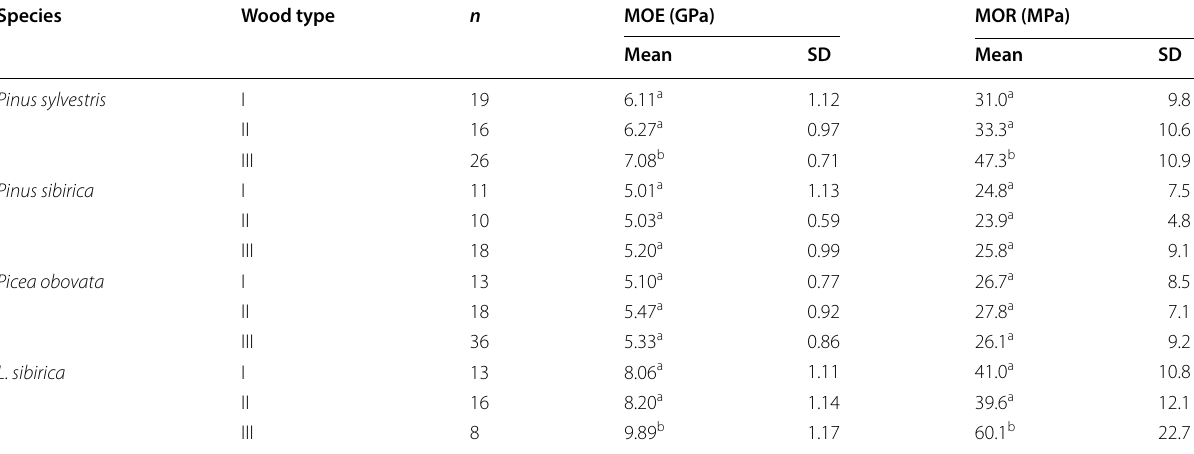
n , number of lumber; MOE and MOR, modulus of elasticity and modulus of rupture adjusted to the values at 15% moisture content by the methods described in Japan Housing and Wood Technology Center [27]; SD, standard deviation; I, lumber including pith at almost-center position in cross section; II, lumber obtained near the pith (sometimes including pith on the surface area of the lumber); III, lumber obtained from outer part of the logs (without pith). The same letters followed by mean values in each species indicate no significant differences at the 5% level according to the Tukey-HSD test